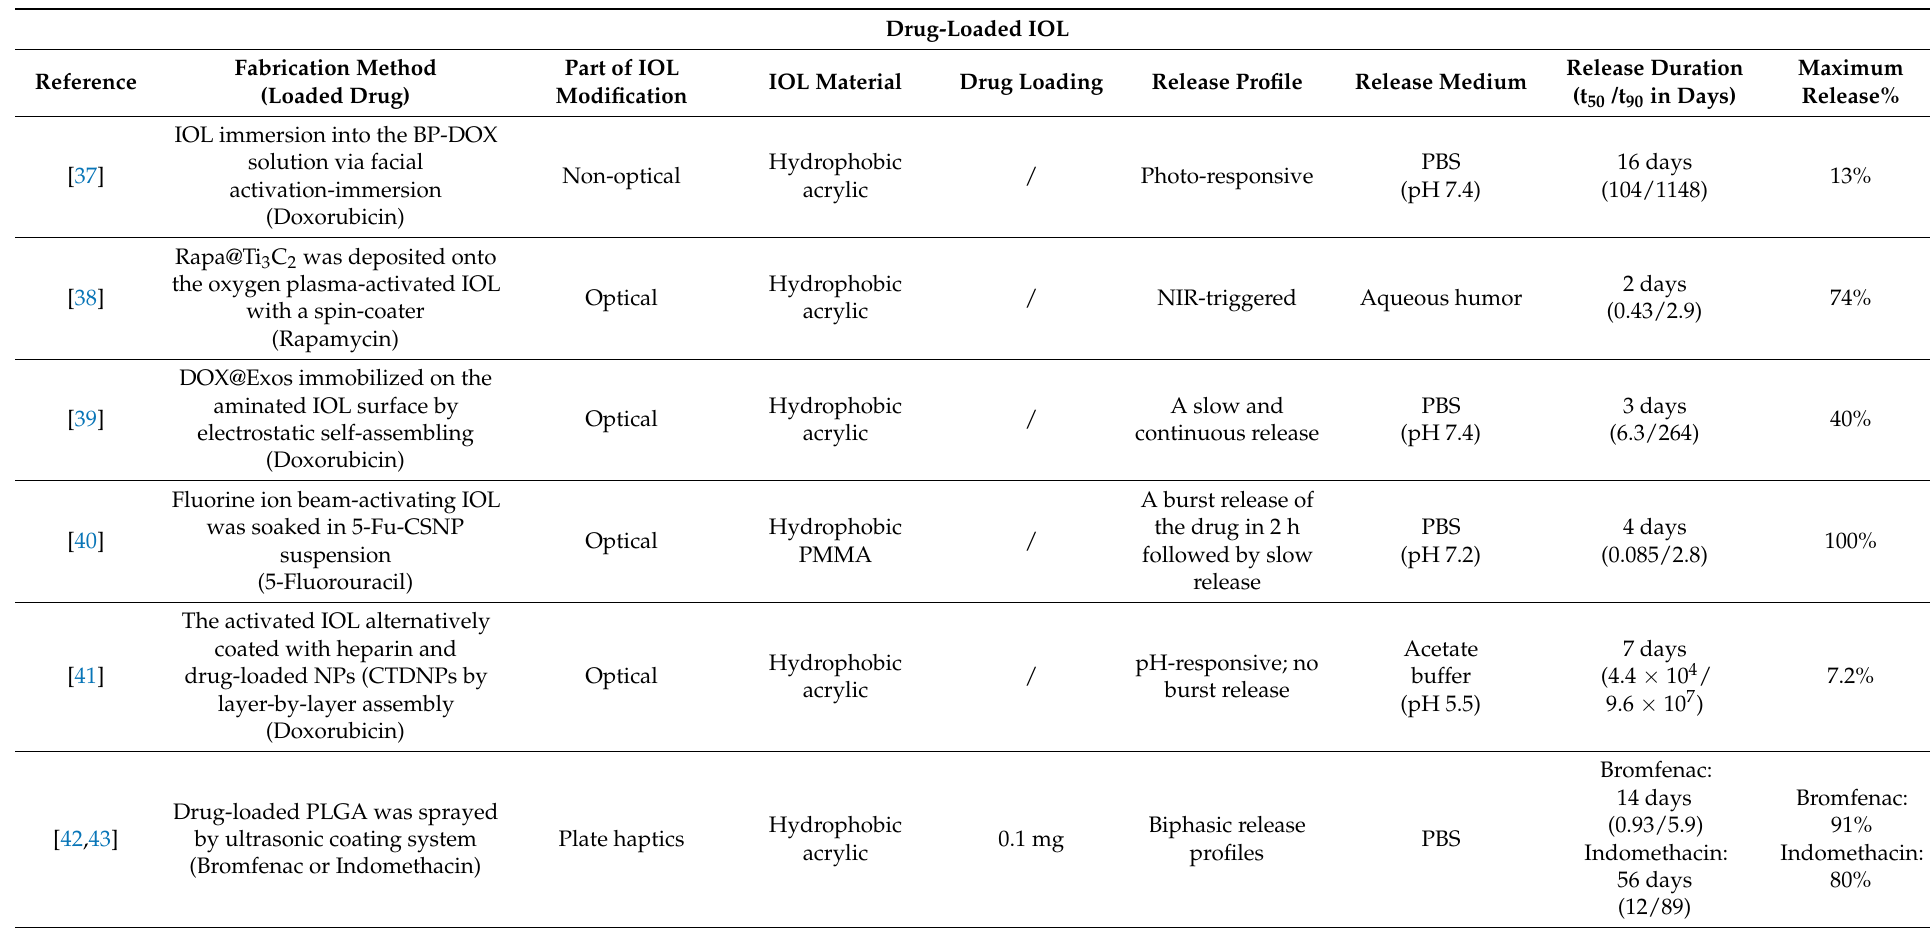
Table 2. Nanotechnology enabled drug delivery for PCO